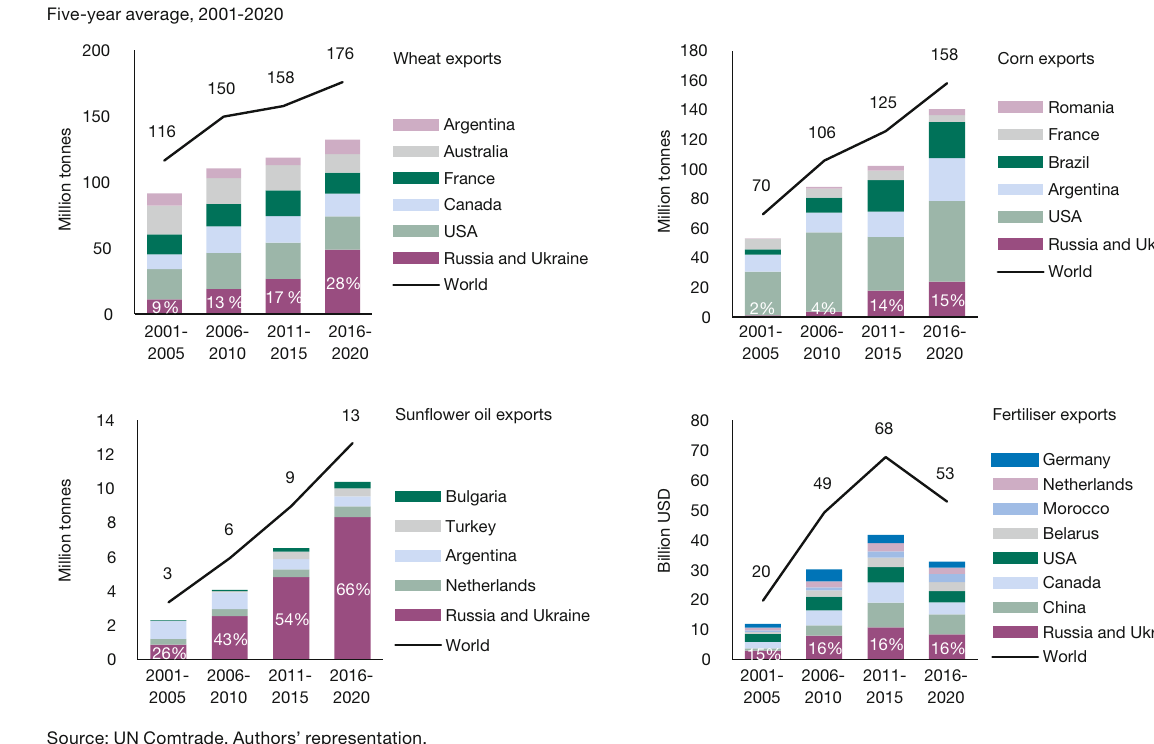
Figure 1 Wheat, corn, sunfl ower oil and fertiliser exports on the world